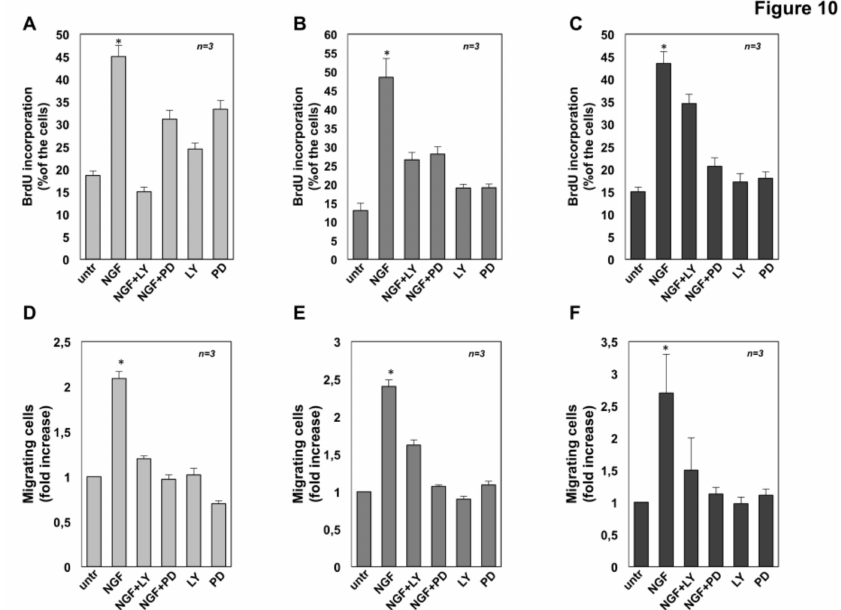
Figure 10. Inhibition of Akt or extracellular signal-regulated kinase (ERK) impairs the nerve growth factor (NGF)-challenged proliferation and migration in castration resistant prostate cancer (CRPC) cells. C4-2B ( A ), DU145 ( B ) and PC3 ( C ) cells were left untreated (untr) or treated for 18h with the indicated compounds. After in vivo pulse with 100 µ M BrdU, BrdU incorporation was analyzed by IF and expressed as % of total cells. C4-2B ( D ), DU145 ( E ) and PC3 ( F ) cells were used for migration assay in collagen pre-coated Boyden’s chambers. The indicated compounds were added to the upper and the lower chambers. After 7 h, migrated cells were counted as described in Methods and results expressed as fold increase. In A-F , NGF was used at 100 ng / mL; PD98059 (PD) and LY-294002 (LY) were used at 10 µ M. Results from three di ff erent experiments have been collected. Means and standard error of the means (SEMs ) are shown. n represents the number of experiments. * p < 0.05 for the indicated experimental points vs. the corresponding untreated